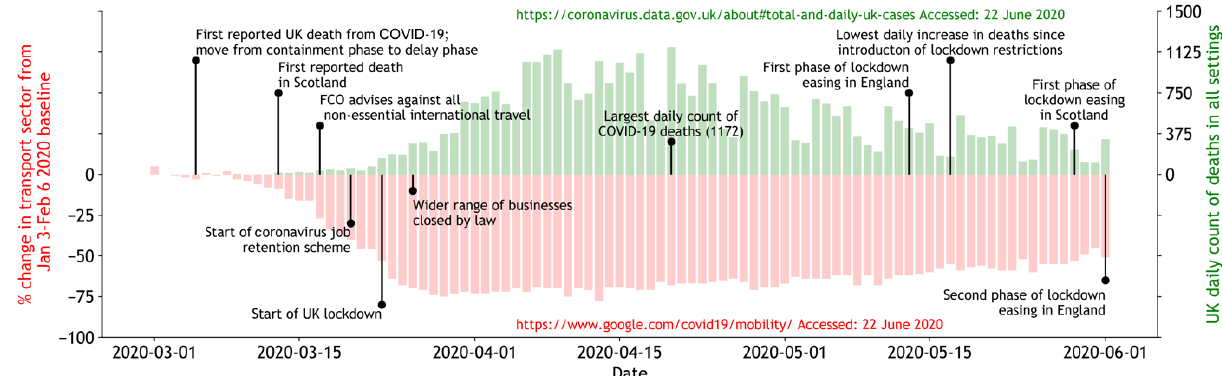
Figure 1. Schematic of the timelines involved with daily mortality values attributed by the UK government to COVID-19, and changes in mobility from the transport sector (inferred from Google location data on smartphones) compared to a reference period (3 January–6 February 2020) before the lockdown period. Also included are key dates that describe the run-up and evolution of the UK lockdown. Data acknowledgements are shown inset on the